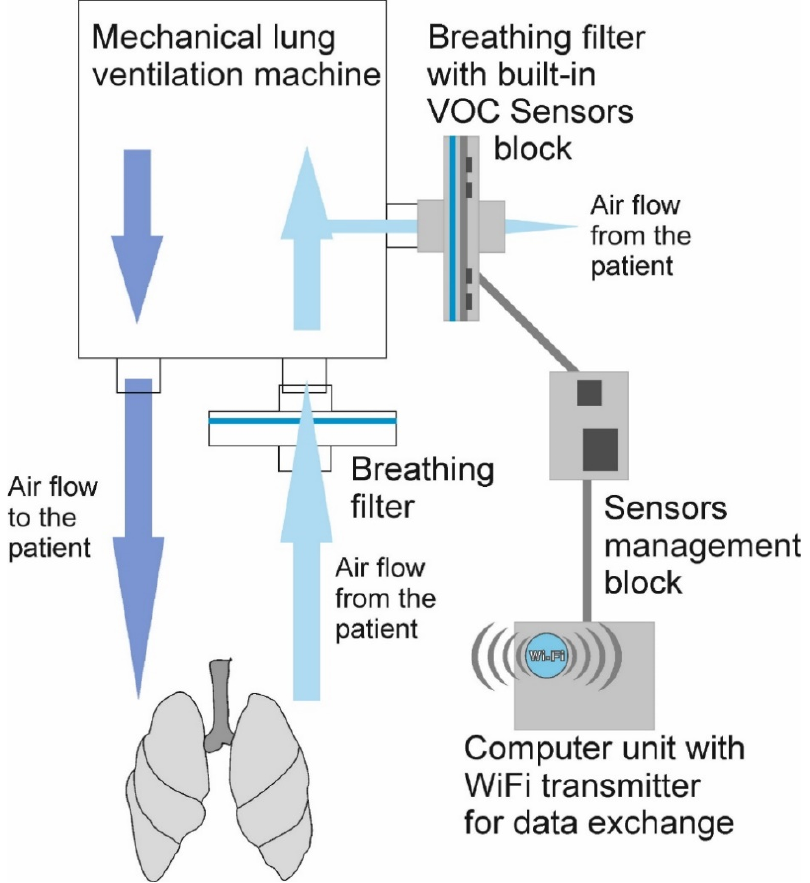
Figure 4. Schematic of the VOC sensor device placement including the ventilation airways and sensors’ signal acquisition for the monitoring of COVID ‐ 19 patients.